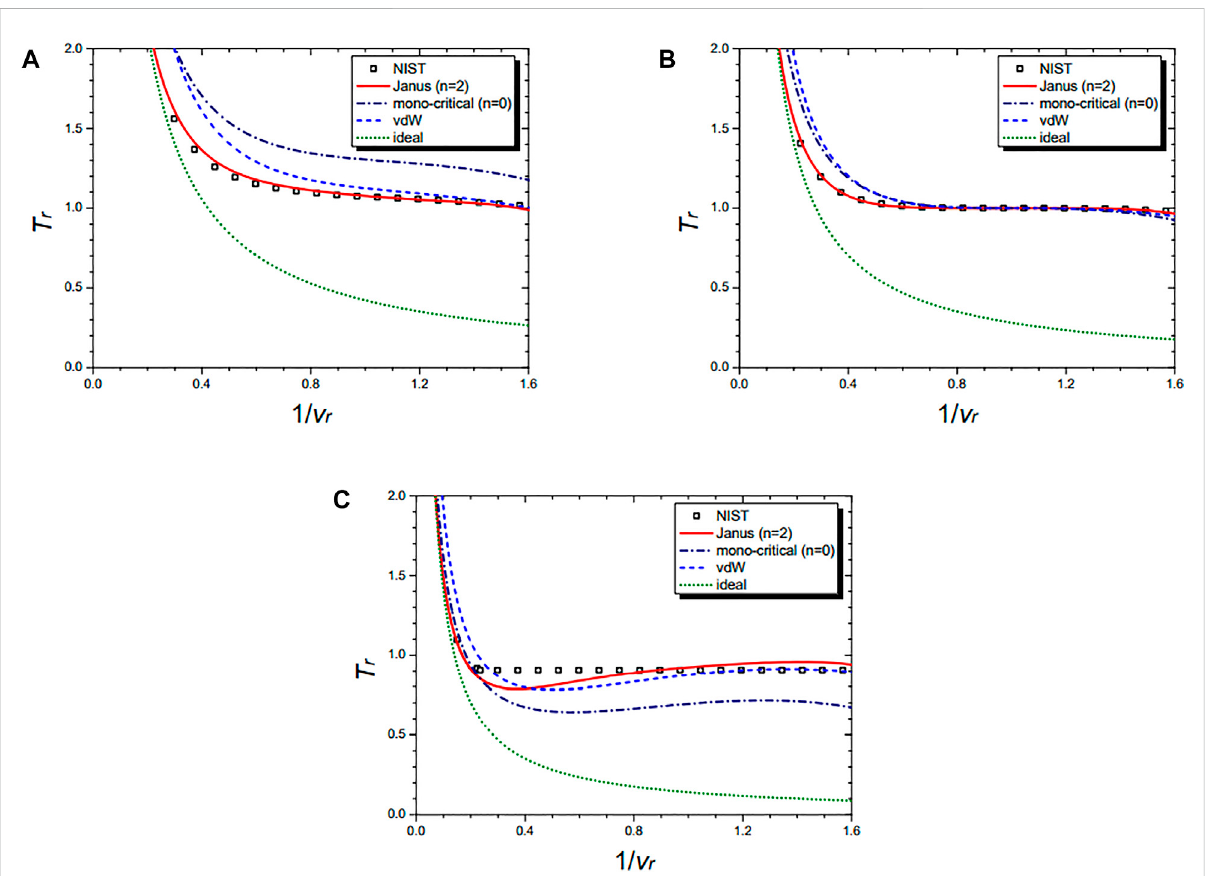
Isobariccurvesofcyclopentane(C 5 H 10 )at P r =1.5 (A) , P r =1.0 (B) ,and P r =0.5 (C) ,respectively.BoxesarefromtheNISTdata.Theredsolidlineis drawnfromthe n =2JanusvanderWaalsEq.23andisbetter fi ttedthanthe n =0mono-criticalEq.21,theoriginalvanderWaalsEq.1,ortheclassical ideal gas law